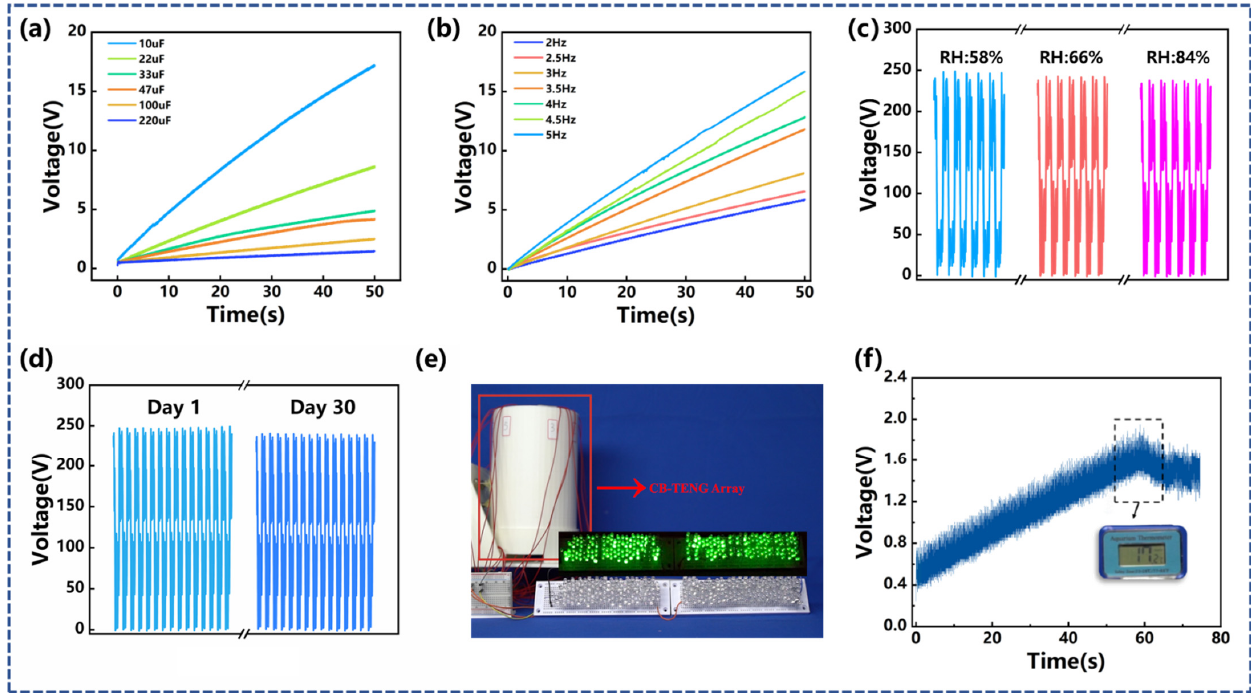
Figure 6. Demonstration applications: ( a ) Voltage of different capacitors (C = 10, 22, 33, 47, 100, and 220 μ F) charged by array-type CB-TENG at f = 3 Hz, A = 50 mm; ( b ) voltage of the same capacitor (C = 33 μ F) charged by array-type CB-TENG at different vibration frequency and the same vibration amplitude of 50 mm; ( c ) sensitivity of CB-TENG to relative humidity; ( d ) durability of the CB-TENG; ( e ) the array-type CB-TENG lighting 204 LEDs; ( f ) powering a temperature sensor with array-type CB-TENG.